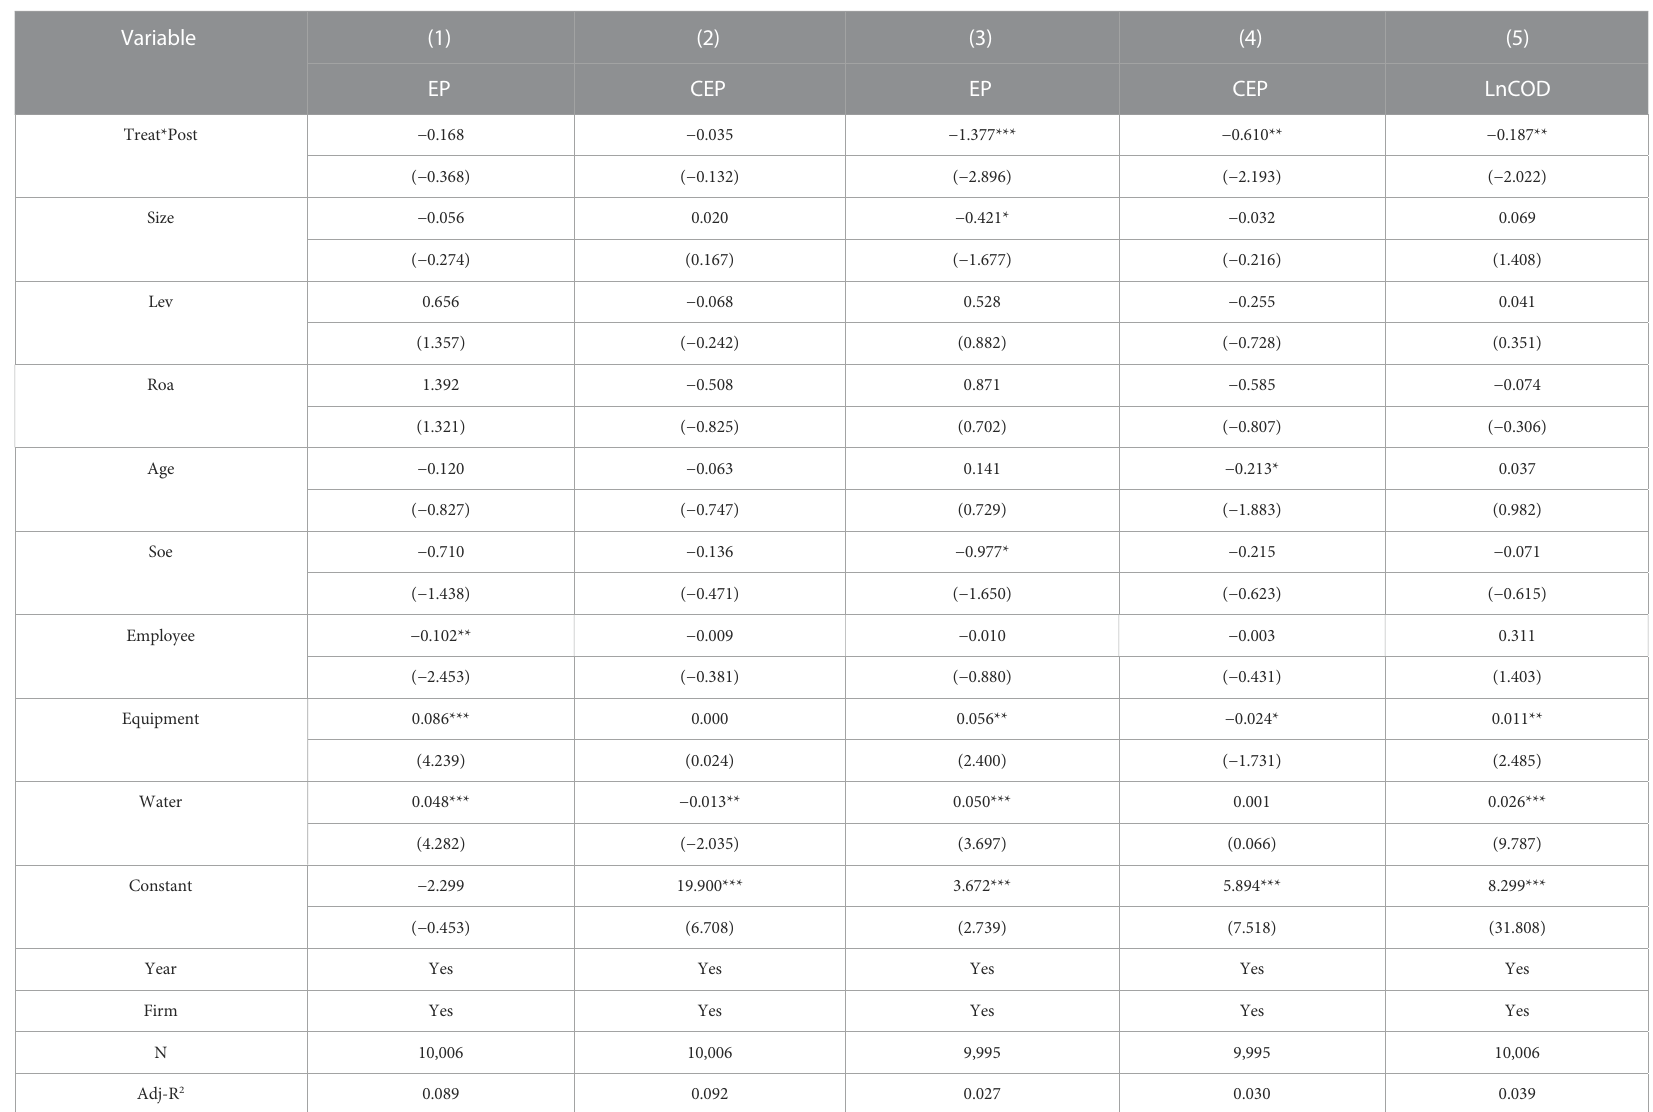
TABLE 7 Robustness